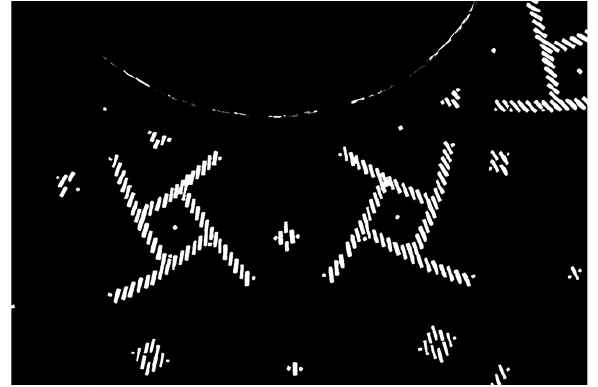
Figure 6. A screen shot of the point selection using masks in Agisoft Metashape.